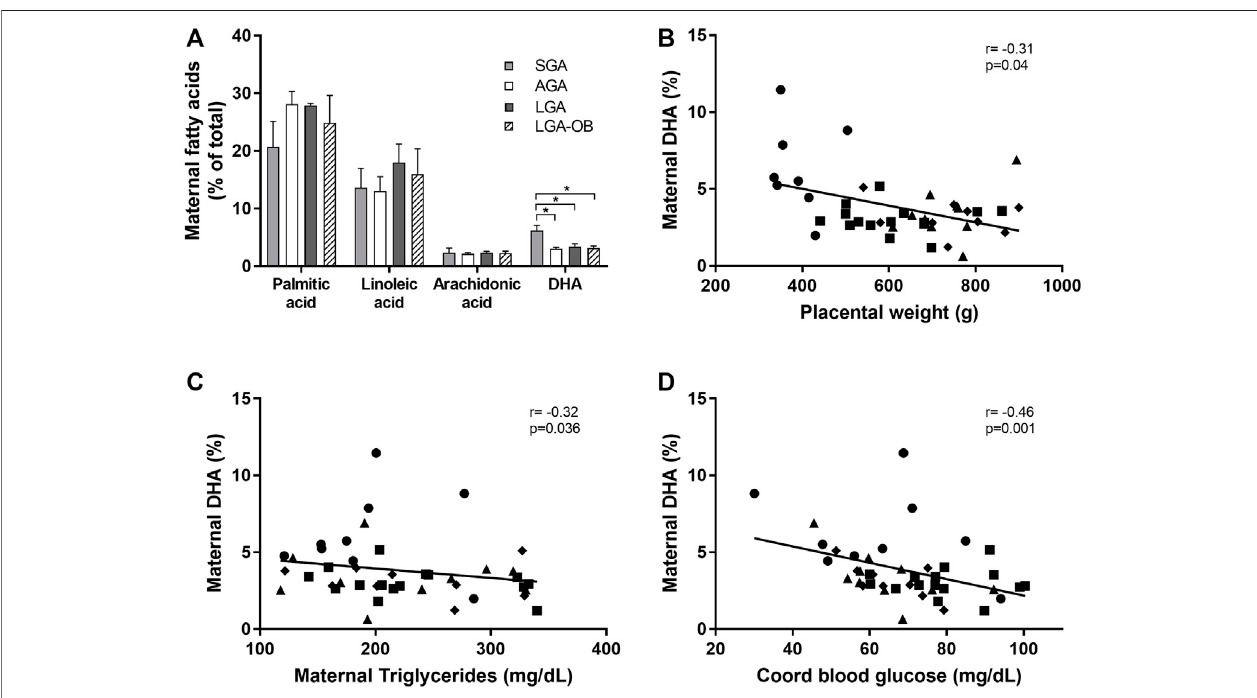
FIGURE5| Maternalserumfattyacidpro fi leandcorrelationofmaternalDHAwithmaternalandneonatalvariables.Maternalserumfattyacids (A) evaluatedbygas chromatography. Fatty acid identi fi cation was made by comparing the retention times with the standards of each of the fatty acids of interest (palmitic, arachidonic, linoleic, and DHA acids) and normalized to the percentage of total fatty acids in the sample. * denotes signi fi cant difference ( p < 0.05) between groups by ANOVA. Correlation between maternal DHA with placental weight (B) , maternal triglycerides (C), and cord blood glucose (D) .